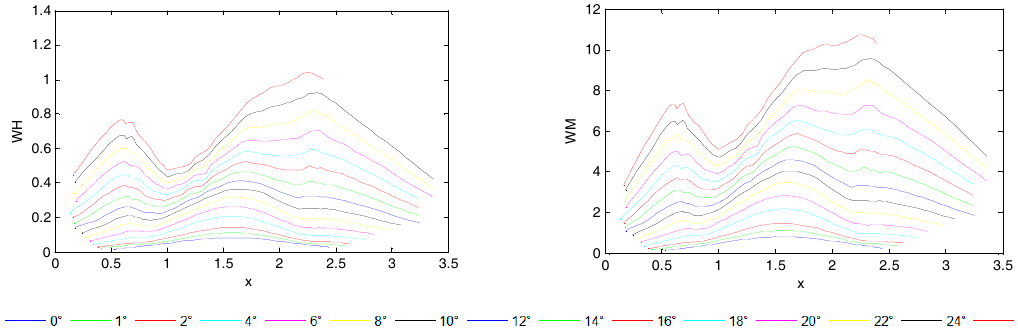
Figure 4. The WH and WM curves transformed by the improved Suter transformation method.